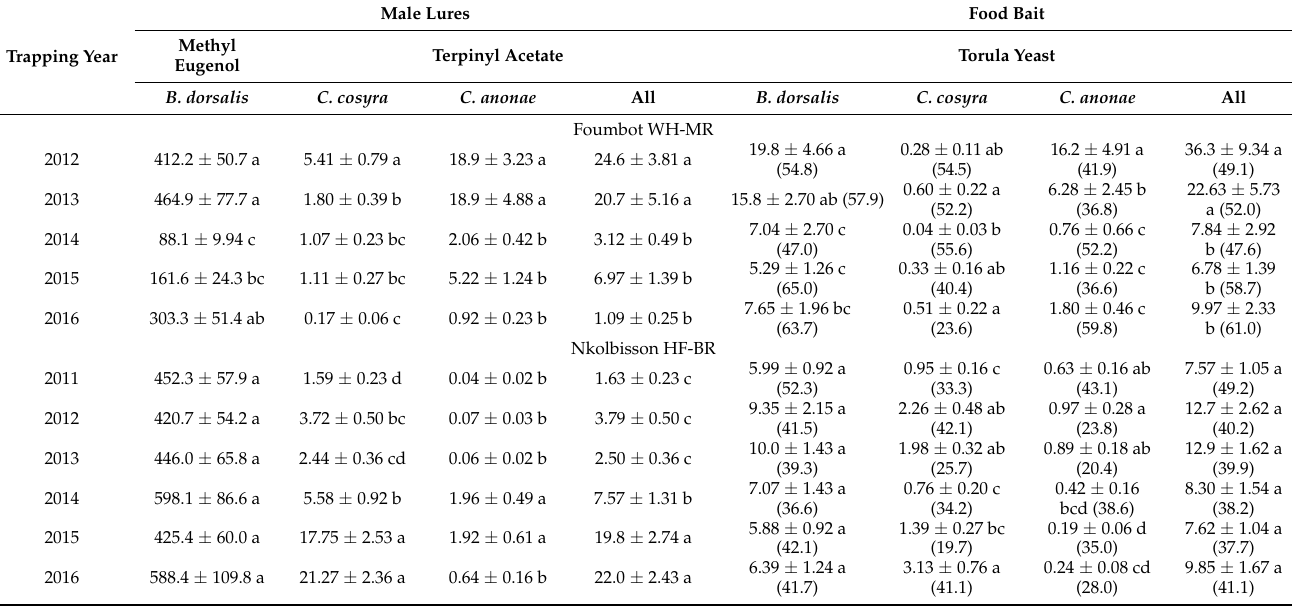
Table 4. Annual fruit fly species captures (means ± SE flies/trap/week) in male lures (methyl eugenol and terpinyl acetate) and food bait (Torula yeast) in 2 agro-ecological zones of Cameroon during the trapping period 2011–2016.